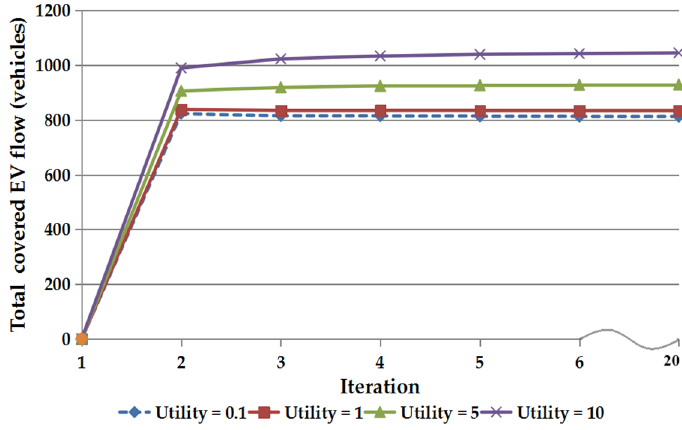
Figure 7. The sensitivity analysis of charging facilities’ utility.